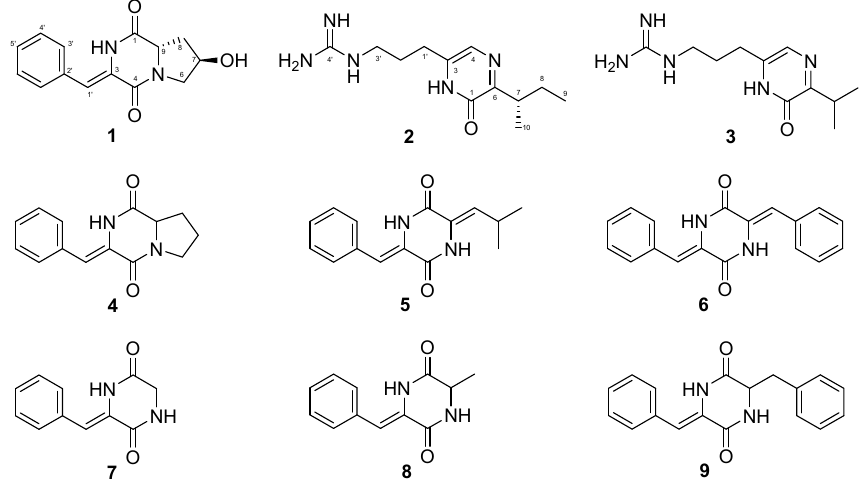
Figure 1. Structures of compounds 1–9.